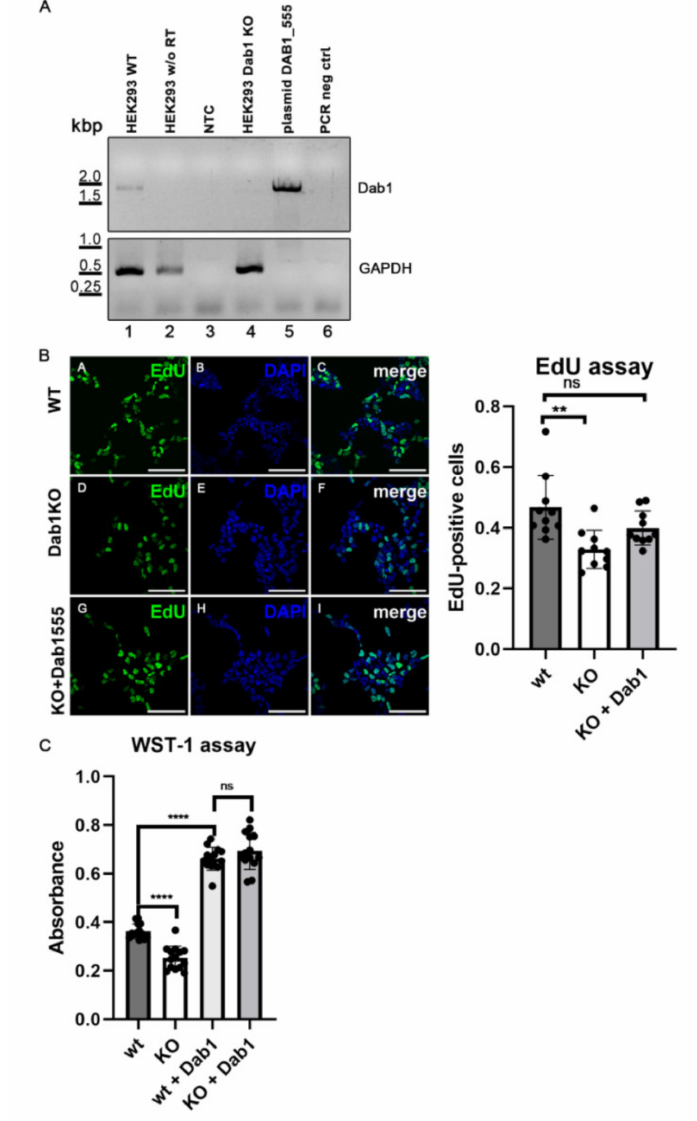
Figure 6. Cell proliferation rate is decreased in Dab1 k.o. cells. ( A ) Validation of HEK293 Dab1 k.o. cells. RNA from HEK293 wt and HEK293 Dab1 k.o. cells was extracted and reverse